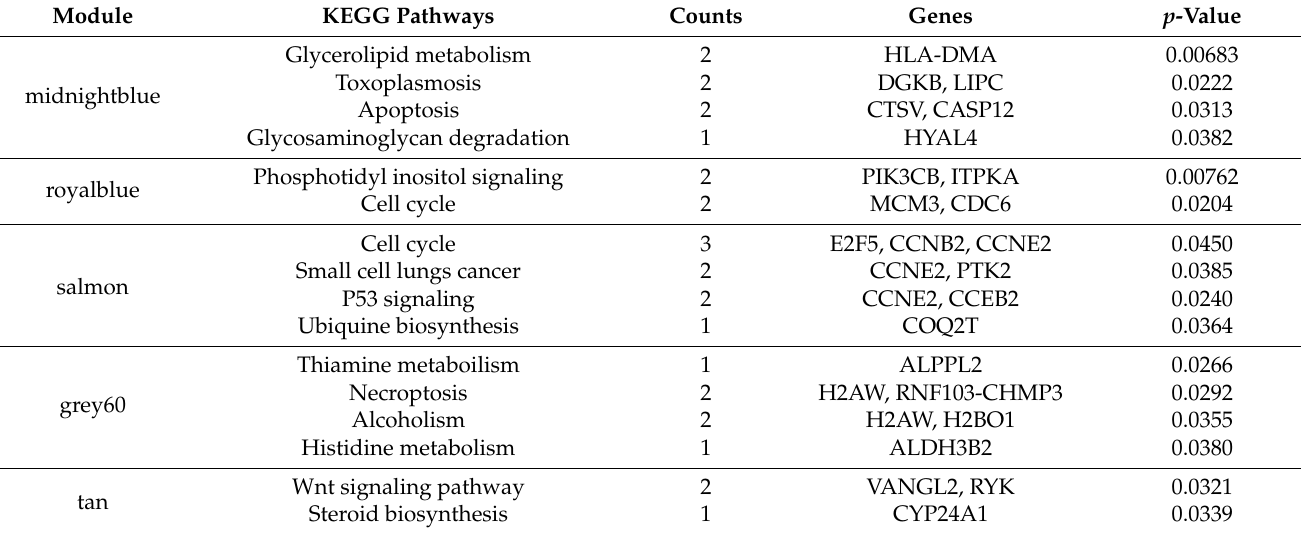
Table 4. Enriched KEGG pathways associated with non-preserved modules identified from GBC